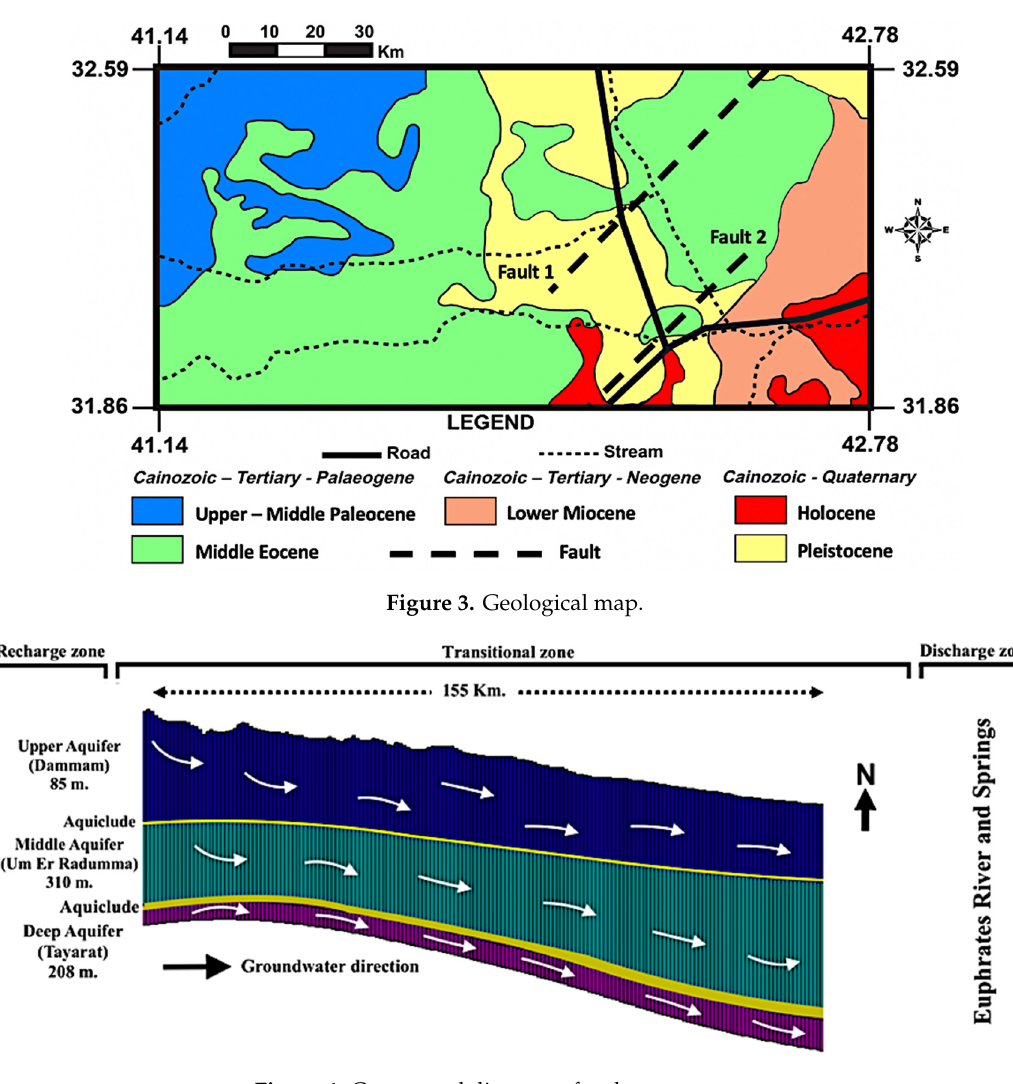
Figure 4. Conceptual diagram of recharge processes . Table 1. Aquifers characteristics [ 24 ] .